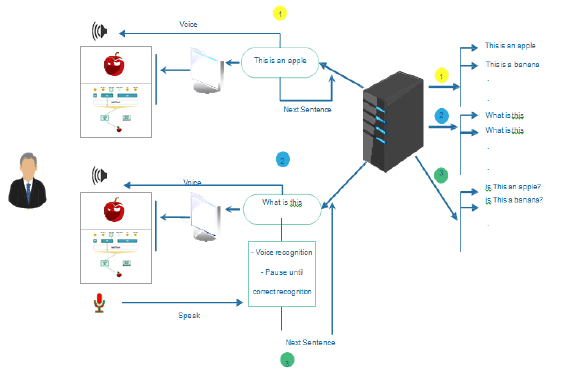
Fig. 11. Functional diagram of the